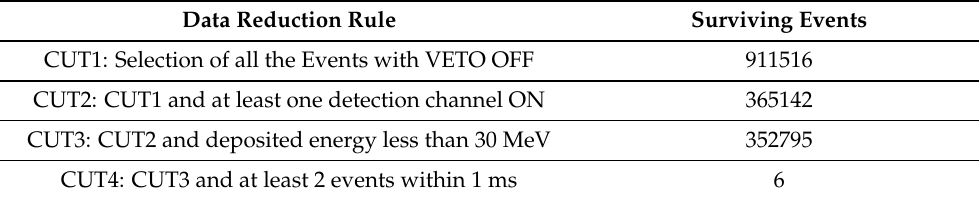
Table 4. Data reduction protocol used in order to discriminate the event from the particle background composed of 1,000,000 of